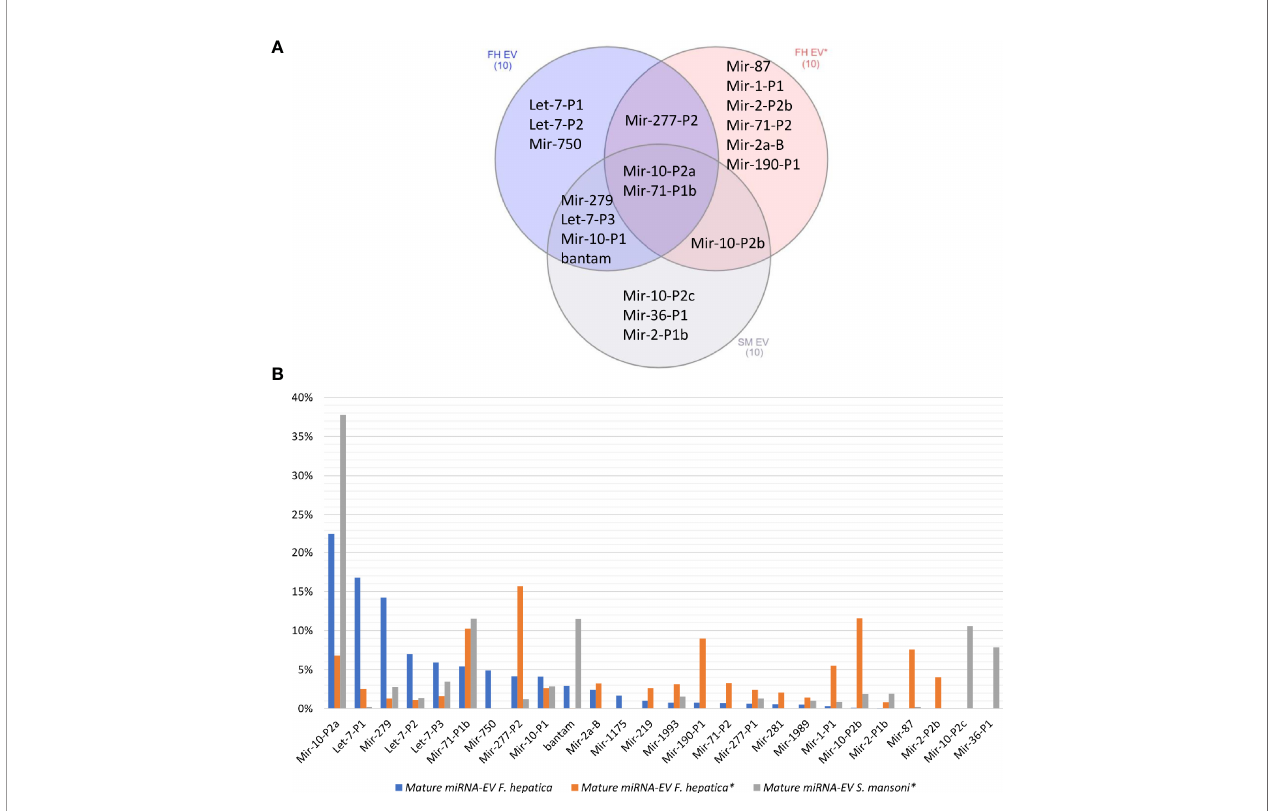
FIGURE 4 | (A) Venn diagram of the top 10 abundant miRNAs in the EVs of two F. hepatica experiments and S. mansoni . (B) Bar plot shows the percentage of the total represented by the most abundant orthologous miRNAs. (*) Data generated by (Ovchinnikov et al.,